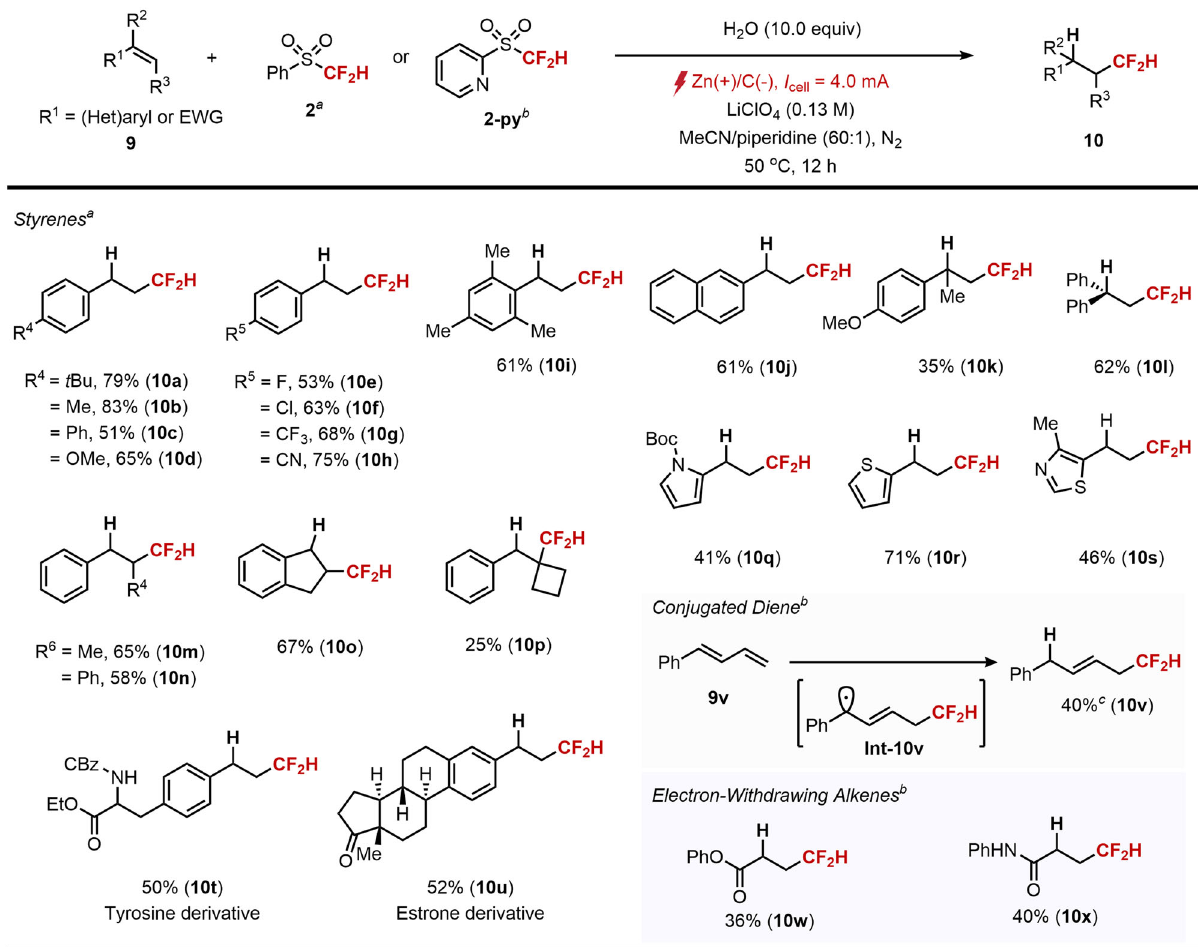
Fig. 5 Substrate scope of conjugated alkenes a . a 9 (0.2 mmol), 2 (0.4 mmol), H 2 O (2.0 mmol), LiClO 4 (0.8 mmol) in MeCN/piperidine (6.0 mL, 40:1) at 50 °C. b 9 (0.2 mmol), 2-py (0.6 mmol), LiClO 4 (0.8 mmol) and H 2 O (1.0 mL) in MeCN/Et 3 N (14/1, 4.0 mL) at 22 °C. c Yield was measured by 1 H